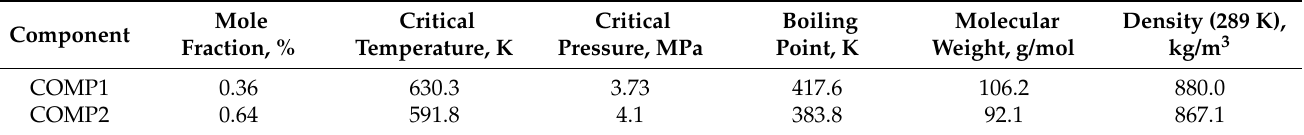
Table 4. Basic parameters data of simulation model.